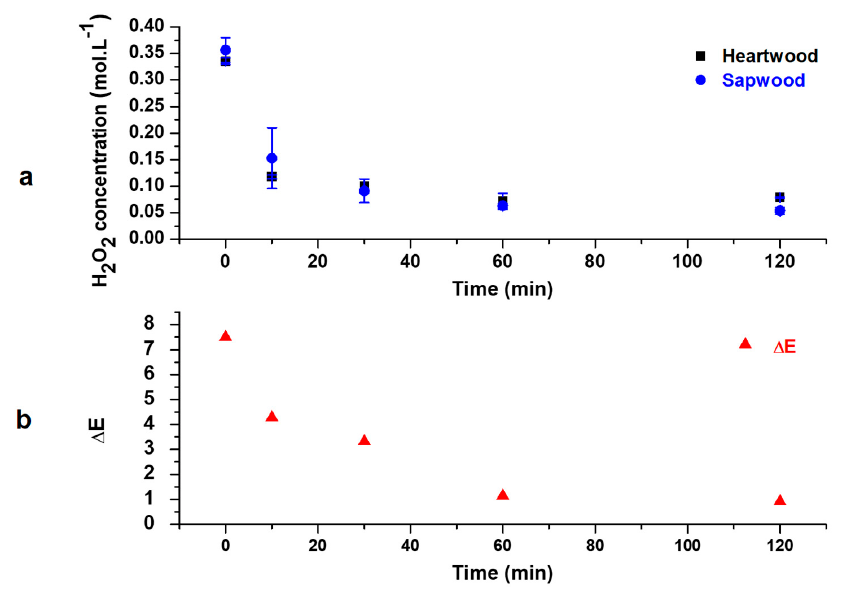
Figure 7. Evolution of H 2 O 2 concentration ( a ) and Δ E Sw/Hw values ( b ) regarding time (4% H 2 O 2 , 1% NaOH, 0.4% Na 2 SiO 3 , 60 °C).